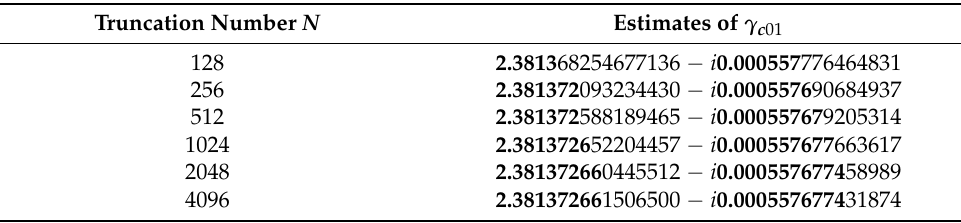
( N ) at truncation number N . c 01